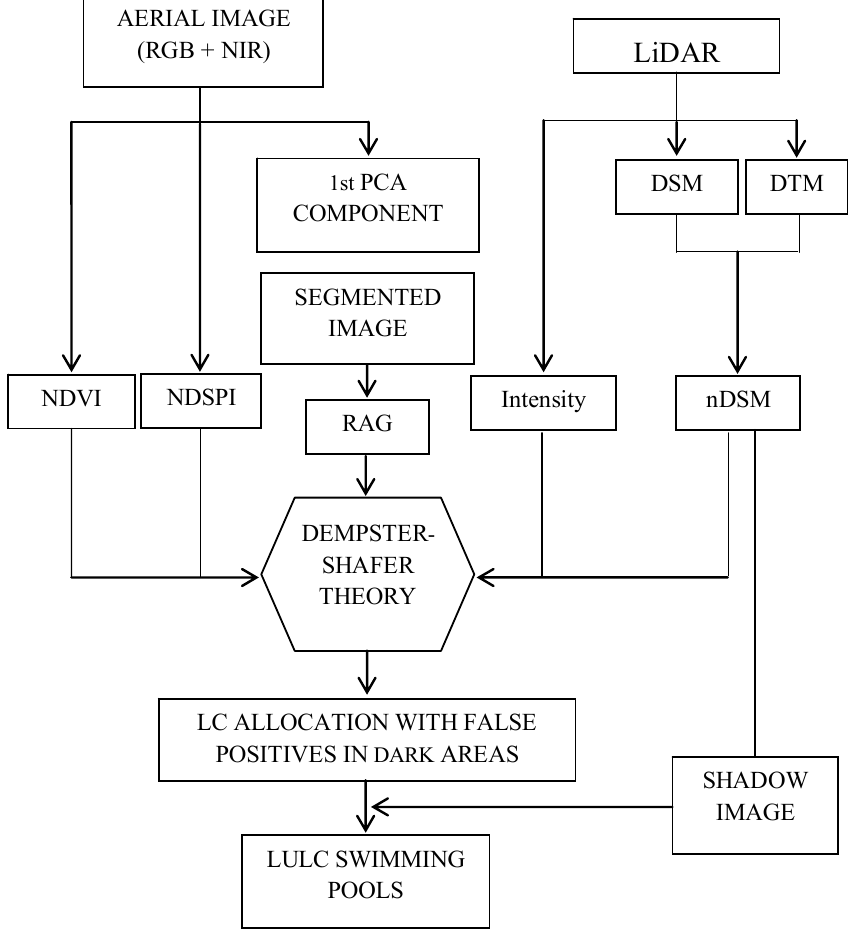
Figure 2. Flow chart of the proposed method for the detection of swimming pools. NIR, near-infrared; PCA, principal component analysis; DSM, digital surface model; DTM, digital terrain model; NDVI, Normalized Difference Vegetation Index; NDSPI, Normalized Difference Swimming Pool Index; RAG, region adjacency graph; nDSM, normalized digital surface model; LULC, land uses and land